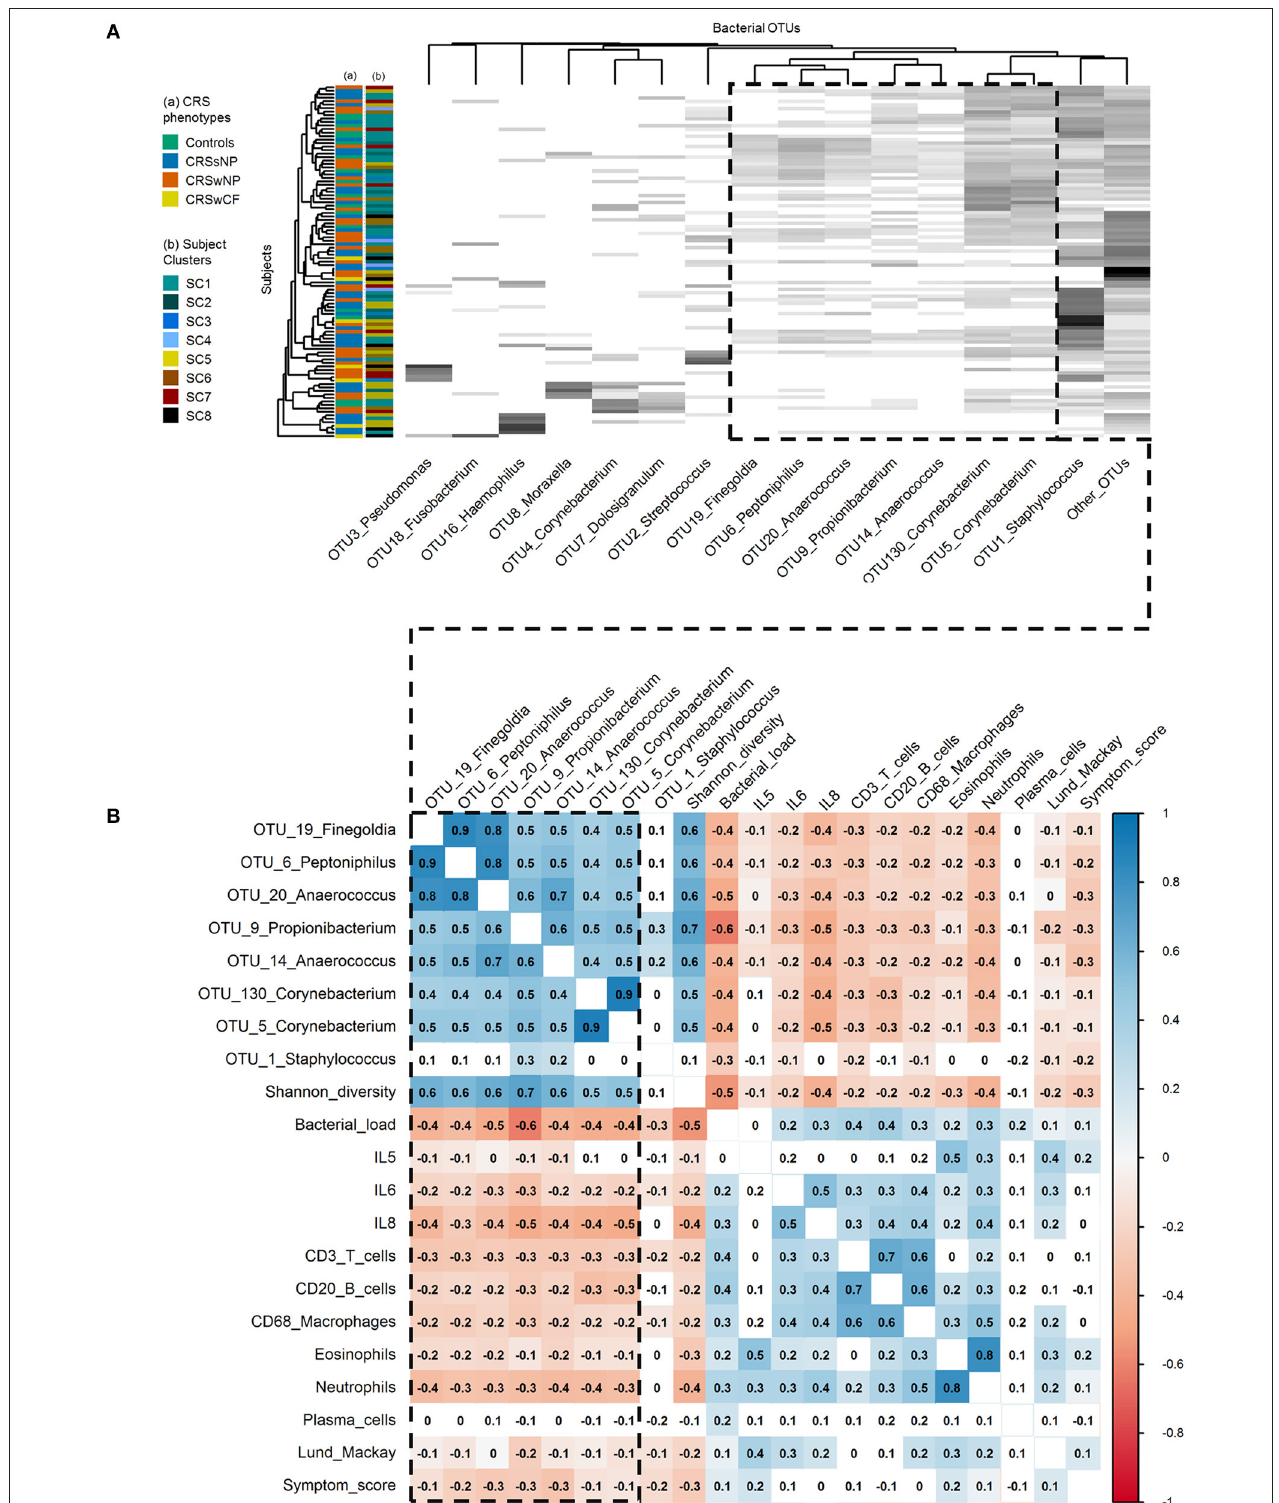
FIGURE 4 | Associations within and between bacterial communities and key inflammatory variables. (A) Heat map of the top 15 bacterial OTUs by subject. Ordering of subjects (rows) and bacterial OTUs (columns) were determined using average linkage hierarchical clustering of bacterial community similarity (based on Bray-Curtis